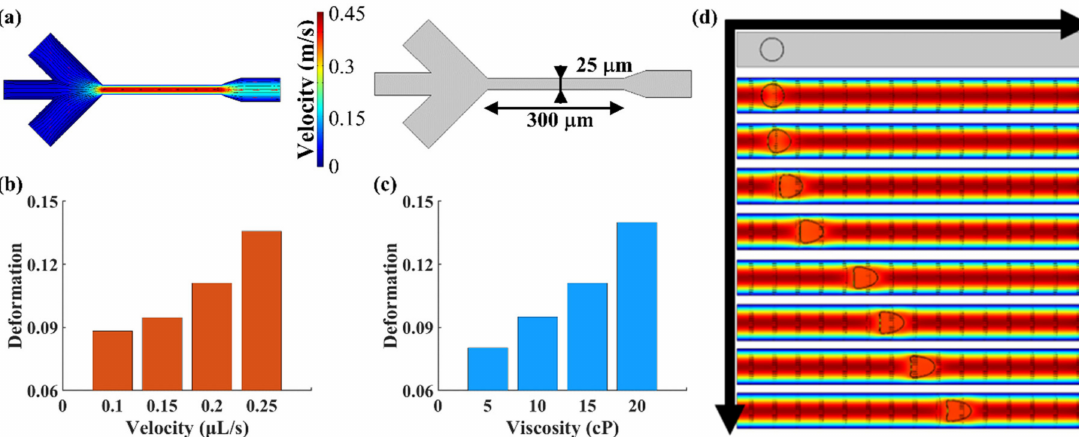
Figure 3. ( a ) The flow field distribution diagram and microchannel geometry. ( b ) Cell deformation under different fluid velocities with a fluid viscosity of 15 cP. ( c ) Cell deformation under different viscosities with a fluid velocity of 0.2 µ L/s. ( d ) The process of cell deformation in the